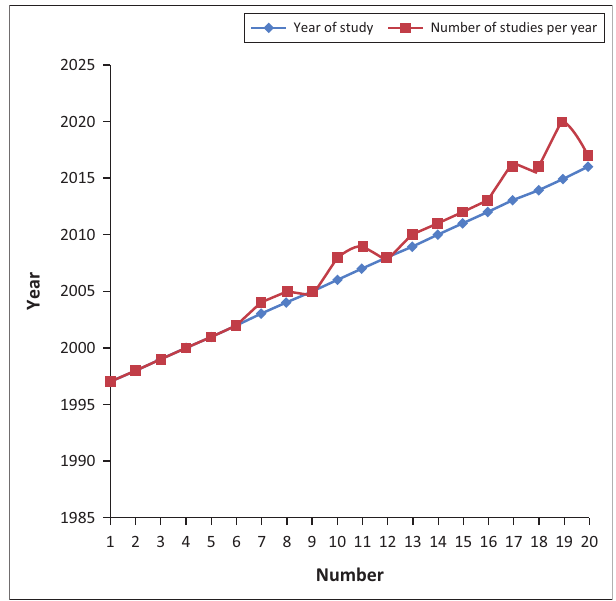
FIGURE 2: Number of studies per year.